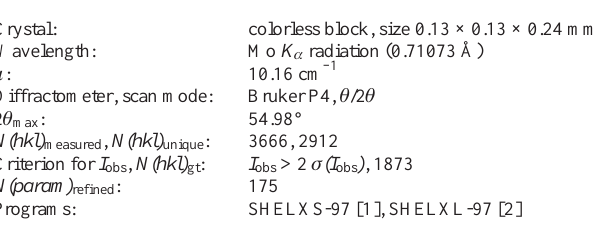
Table 1. Data collection and handling.